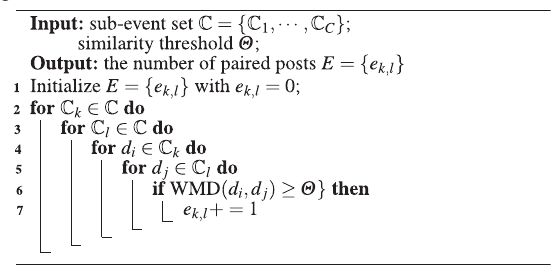
Algorithm 3. Word Mover ’ s Distance (WMD)